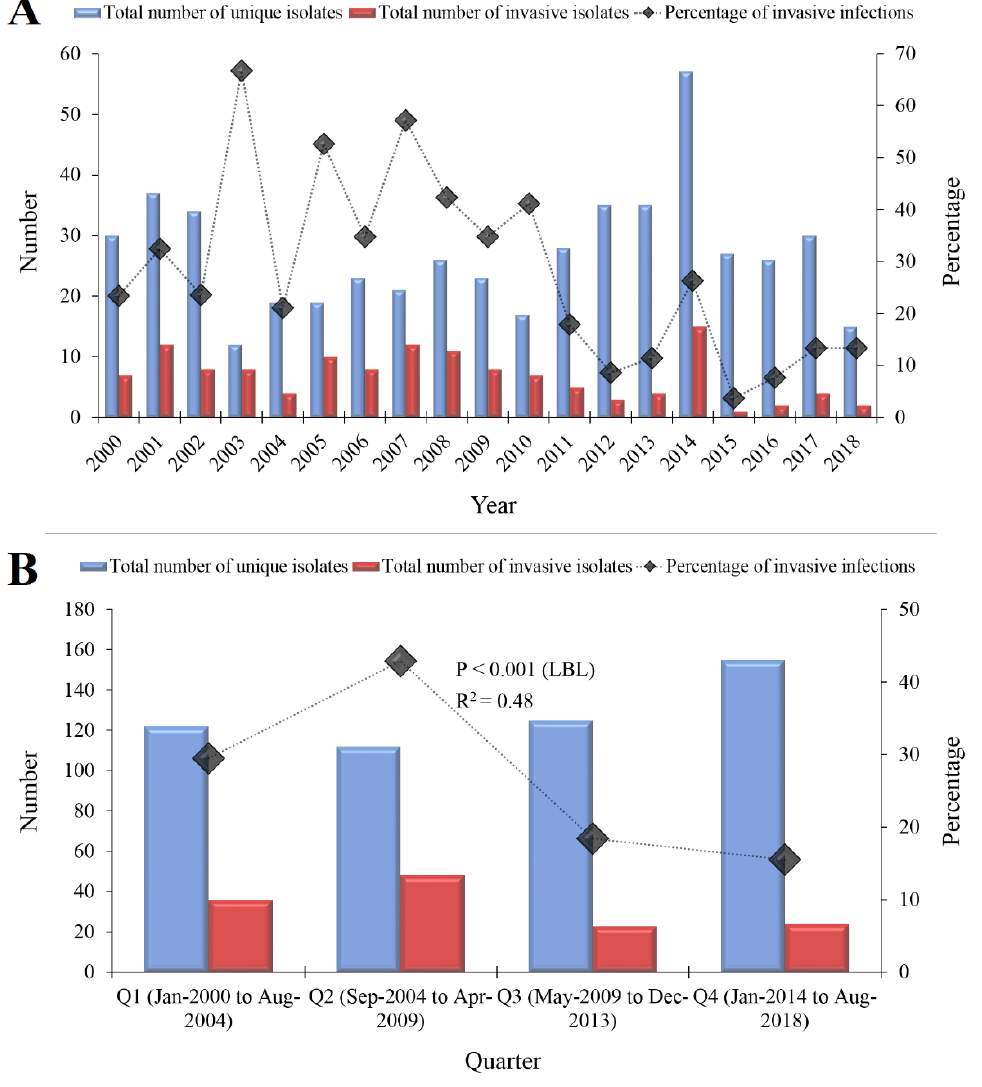
Figure 1. The total number of Streptococcus pneumoniae isolates that were detected at Jordan University Hospital during 2000–2018. ( A ) The total number of S. pneumoniae isolates stratified per year of isolation are shown in blue and the total number of invasive isolates (isolated from sterile specimens) are shown in red. The line plotted on the secondary axis represents the percentage of invasive isolates per year. ( B ) The total number of S. pneumoniae isolates stratified per quarter (each of which represented 56 months) are shown in blue and the total number of invasive isolates are shown in red. The line plotted on the secondary axis represents the percentage of invasive isolates per quarter. A decrease in the proportion of invasive isolates was found over the study period ( p < 0.001, linear-by-linear (LBL) test for association LBL). R 2 represent the correlation coefficient of the trend line. The total number of isolates plotted in the figure was 514, as we were not able to retrieve data on specimen type for a total of 42 isolates.